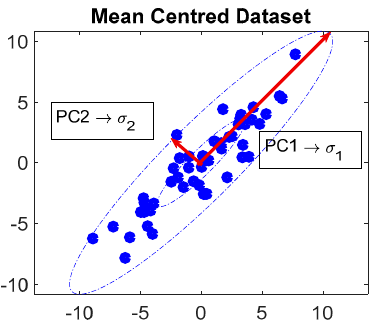
Figure 8. Visualization of the principal component analysis (PCA) principle for a 2D case—geometric interpretation.